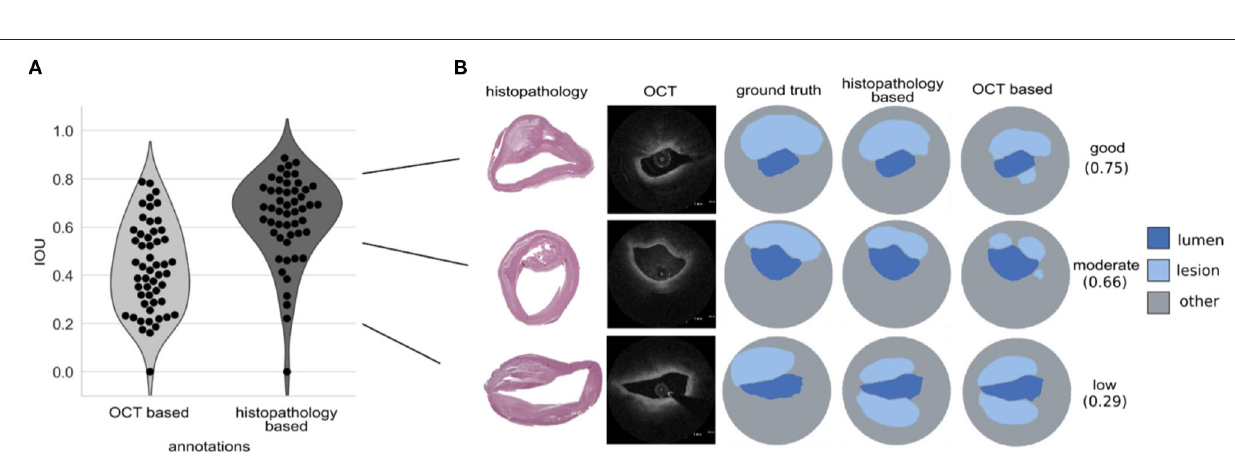
Frontiers in Cardiovascular Medicine |